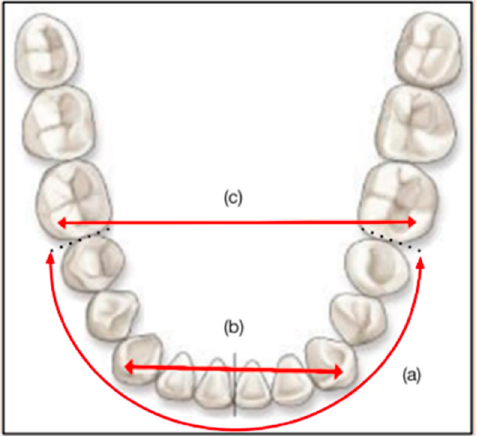
Figure 2. Indicative diagram of ( a ) mandibular crowding, ( b ) inter-canine distance, and ( c ) inter- molar distance (red lines). distance (red